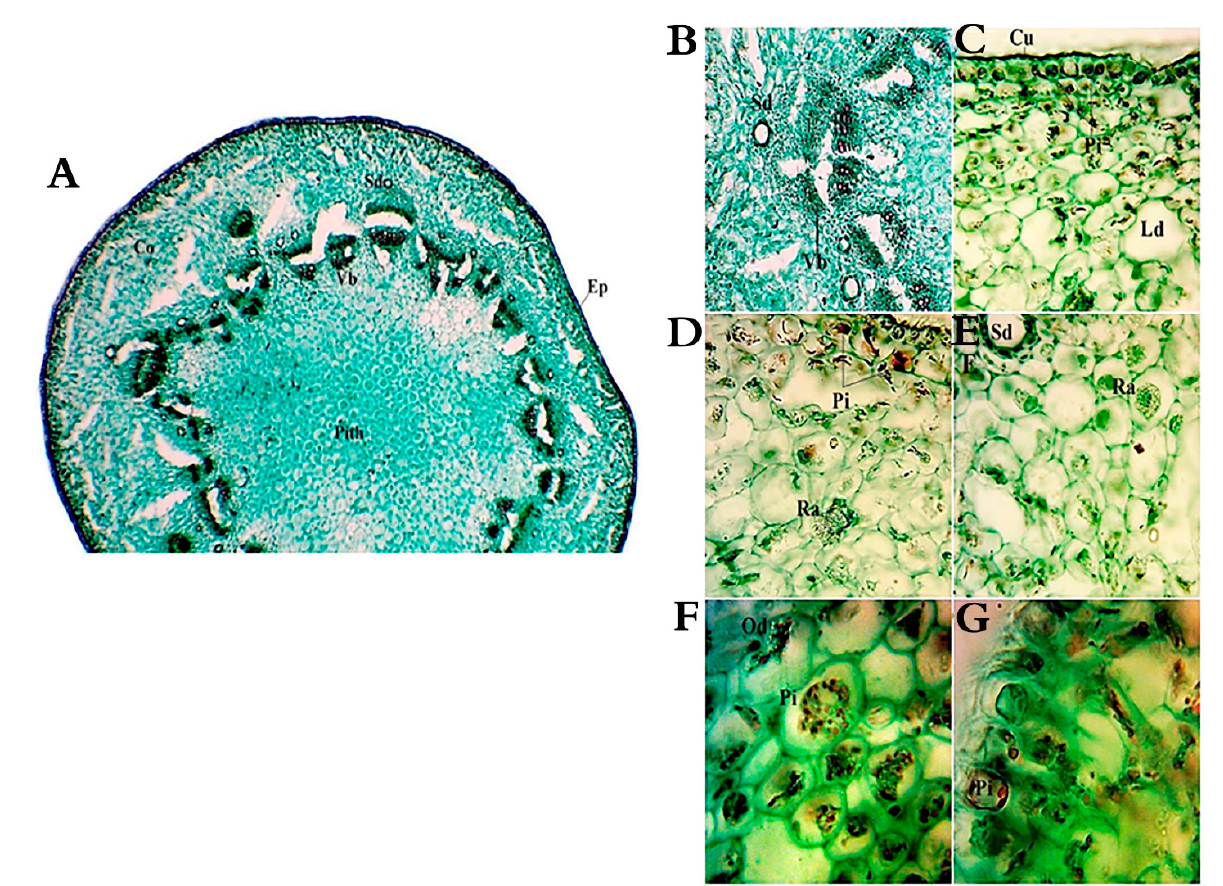
Figure 4. Anatomy of L. crithmoides stem. ( A ) A transverse section in stem, Ep: epidermis, Co: cortex, Sd: schizogenous duct, Vb: vascular bundle; ( B ) enlarged vascular-bundle (Vb); ( C ) cuticle (Cu), Pi: phenolic idioblasts, Ld: lysigenous duct; ( D , E ) raphides crystals (Ra); ( F , G ) oil drops (Od). Bar: A = 40 µm, B–E = 100 µm, F–G = 400 µm.